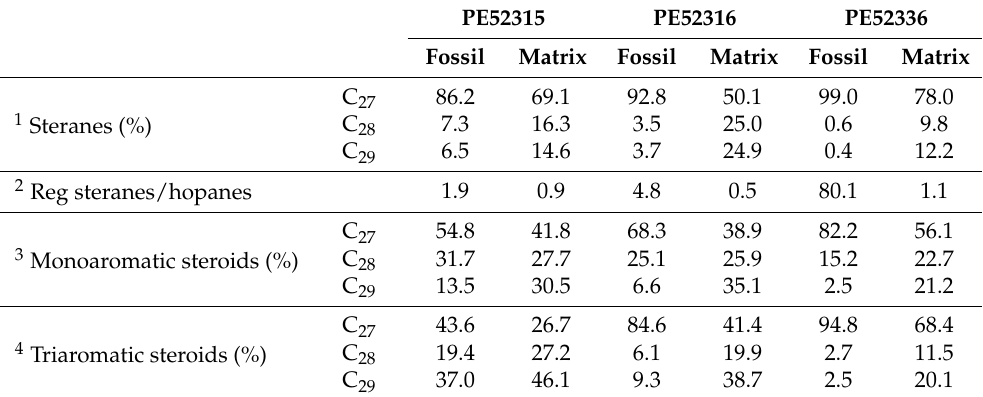
Table 1. Steroid distributions in extracted organic matter.